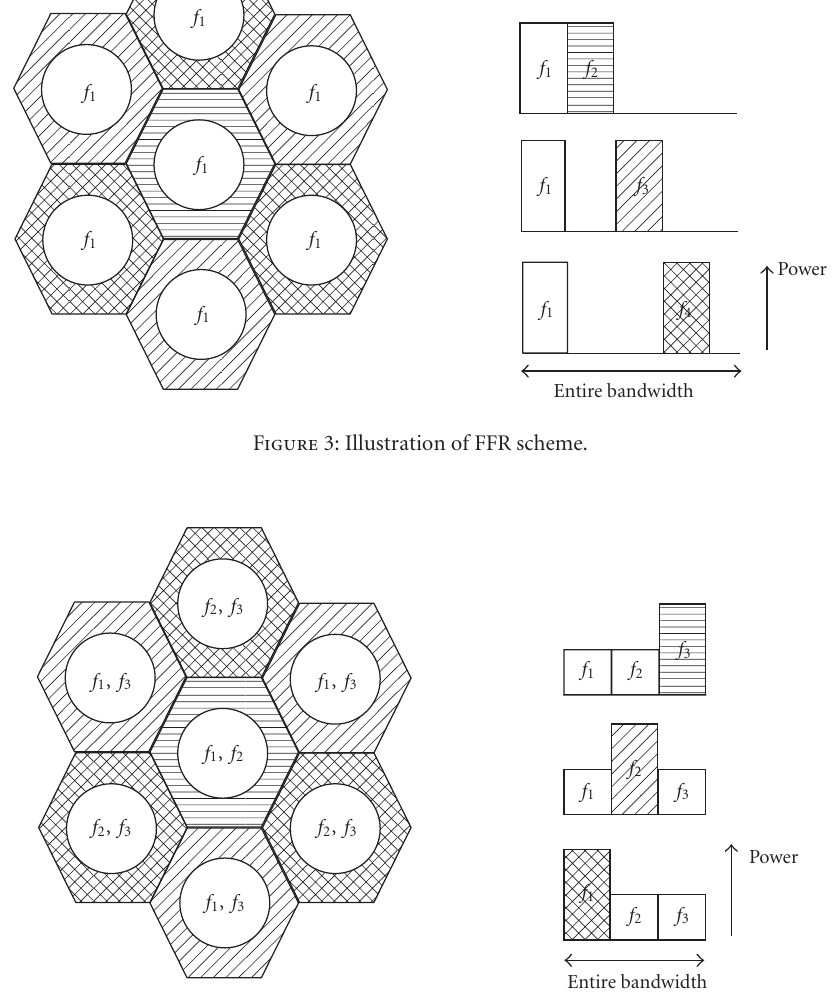
Figure 4: Illustration of SFR